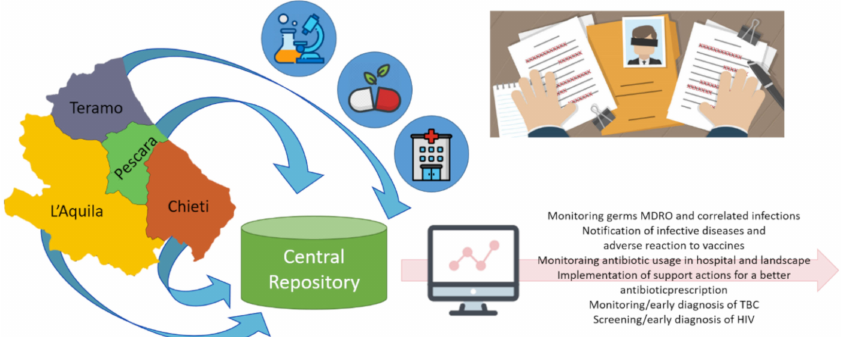
Figure 1. Microbiology data, administration data, discharge notes and drug prescriptions from four provinces are collected into the Central Repository of the